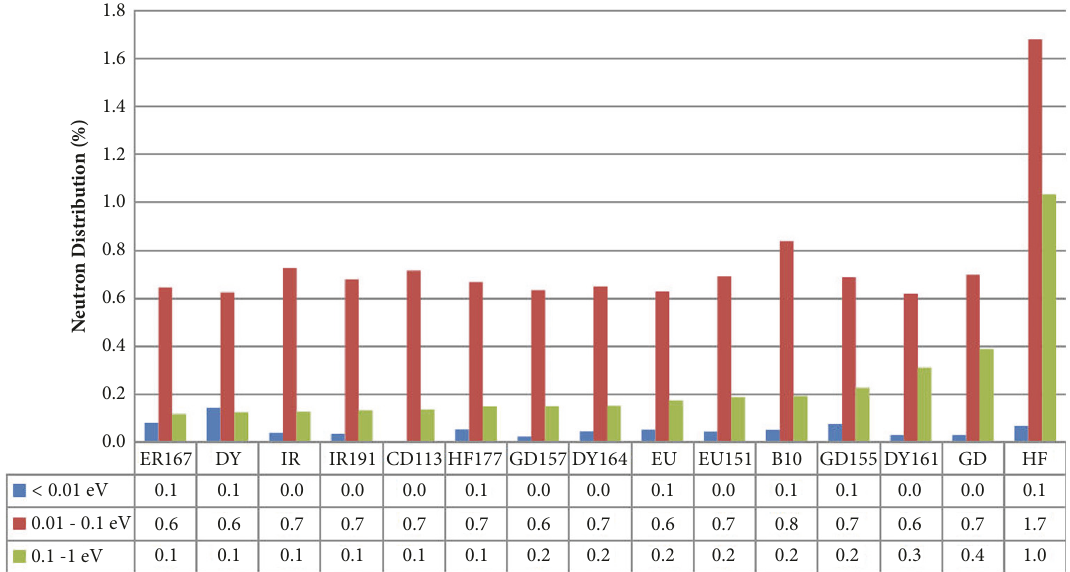
Figure 7: Neutron population distribution at three thermal energy groups (1-0.1eV, 0.1-0.01eV, and < 0.01eV) for all tested materials at 1.0 cm thickness.